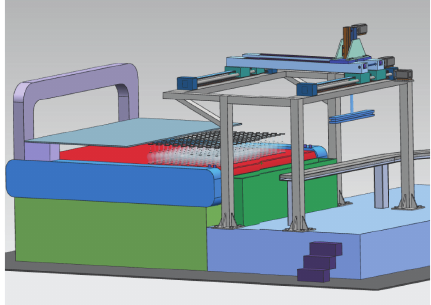
Figure 1: Three-dimensional model of the glass-handing